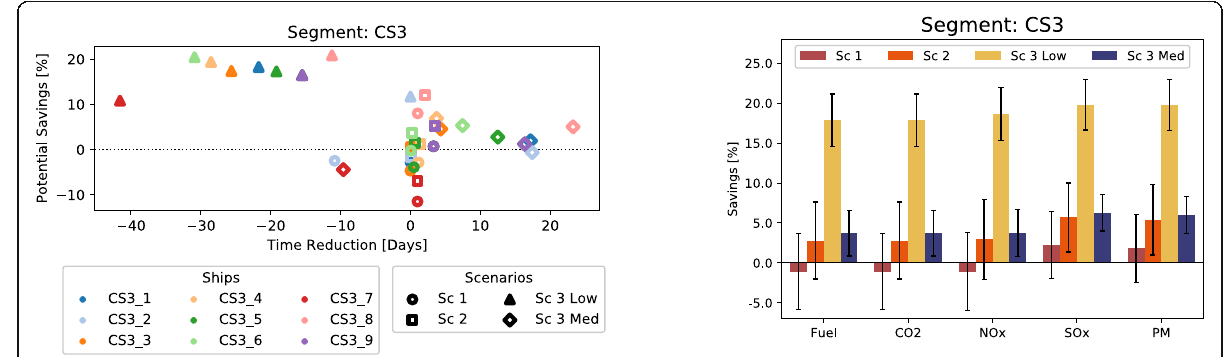
Fig. 10 CS3 ships benefit less from increased efficiency in ports due to the long routes they follow. Similarly, low speeds would imply and excessive increase in navigation time. However, better synchronization an, hence, less speed dispersion, jointly with a careful speed selection could lead to an scenario in between Sc 3 Low and Median with still substantial reductions without sacrificing navigation